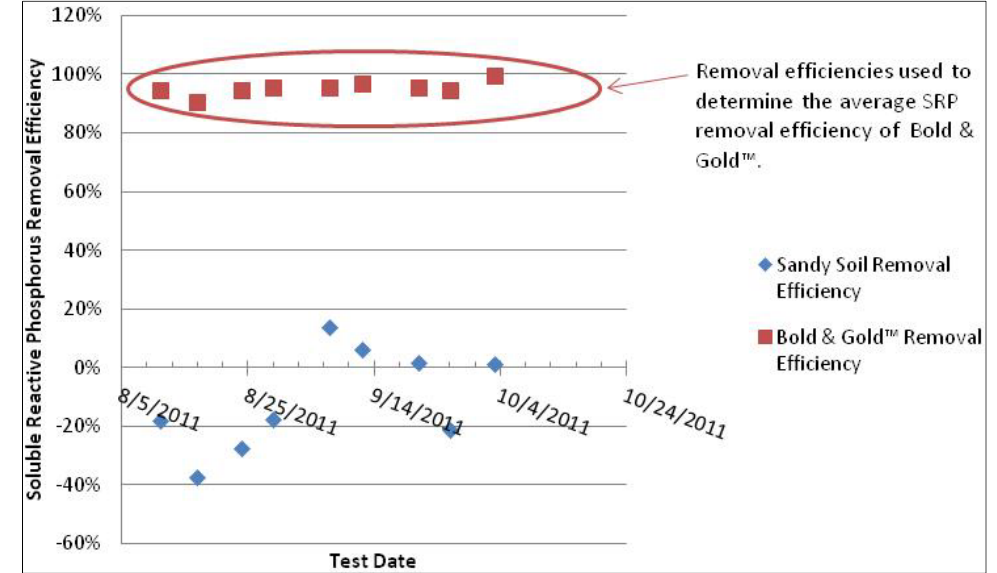
Figure 9. SRP removal efficiencies of field scale bio-filtration